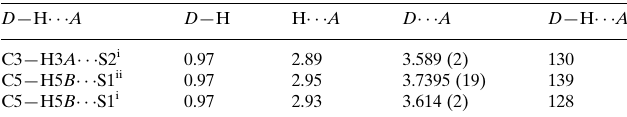
Hydrogen-bond geometry (A˚ , (cid:3)